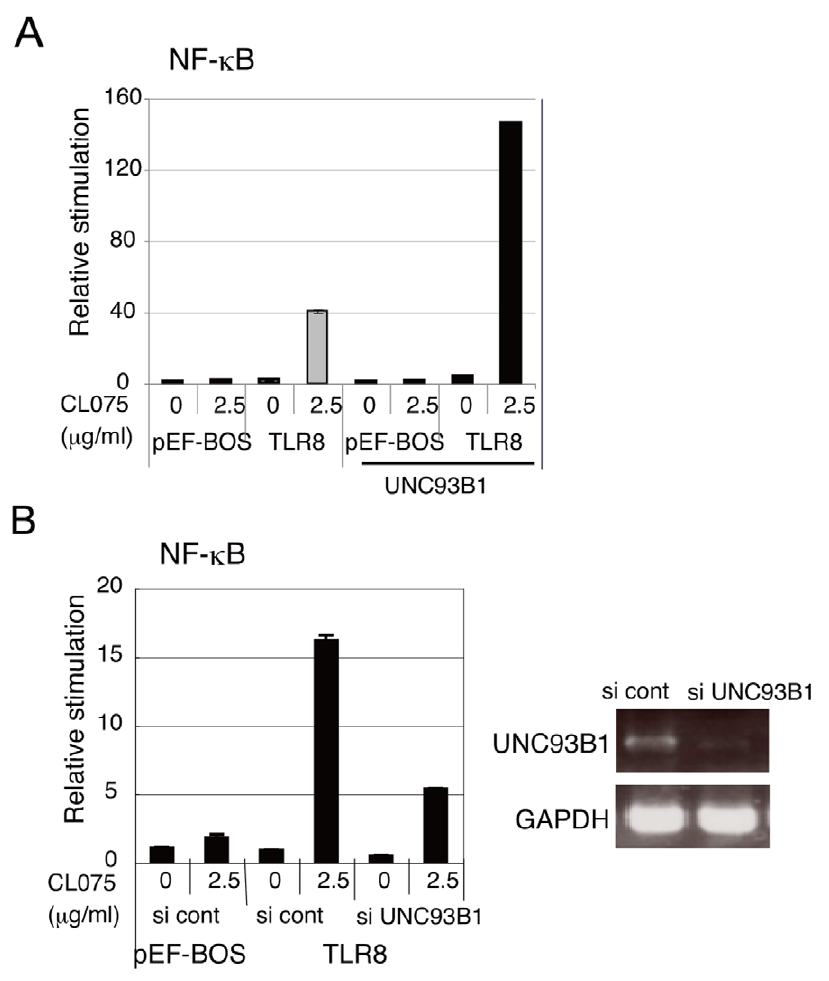
Figure 5. UNC93B1 is indispensable for TLR8-mediated signaling. A , Upregulation of TLR8-mediated NF- k B activation by co-expression with UNC93B. HEK293 cells were transfected with the indicated plasmid together with the ELAM reporter plasmid. Twenty-four hours after transfection, the cells were stimulated with CL075 or left untreated. After 6 hours, the luciferase reporter activities were measured and expressed as the fold induction relative to the activity of unstimulated cells. Representative data from three separate experiments are shown. B , TLR8-mediated NF- k B activation is downregulated by knockdown of UNC93B1. UNC93B1 siRNA or negative control siRNA was transfected into HEK293 cells together with the reporter plasmids and TLR8 expression plasmid. Forty-eight hours after transfection, cells were stimulated with CL075 for 6 hours and the luciferase reporter activities were measured. Data are representative of three independent experiments (mean and s.d. of triplicate assays). The expression of endogenous UNC93B1 and GAPDH mRNAs were examined using RT-PCR 48 hours after siRNA transfection (right